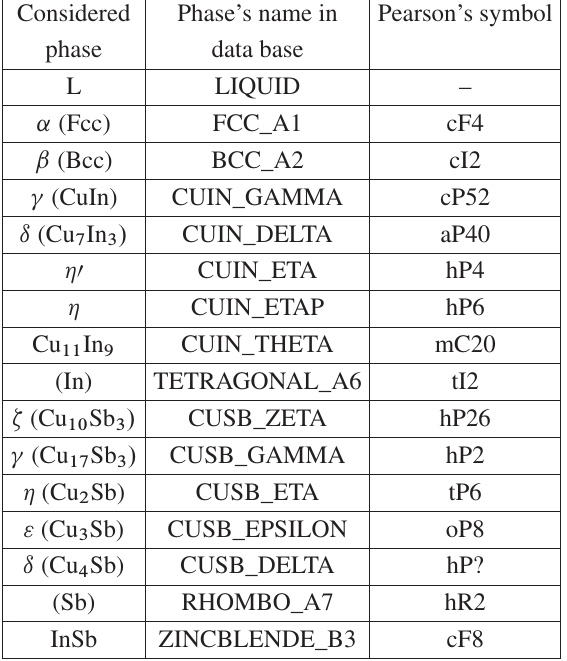
Table 1. Considered phases, phase’s name in the thermody- namic data base and Pearson’s symbols [2,9].